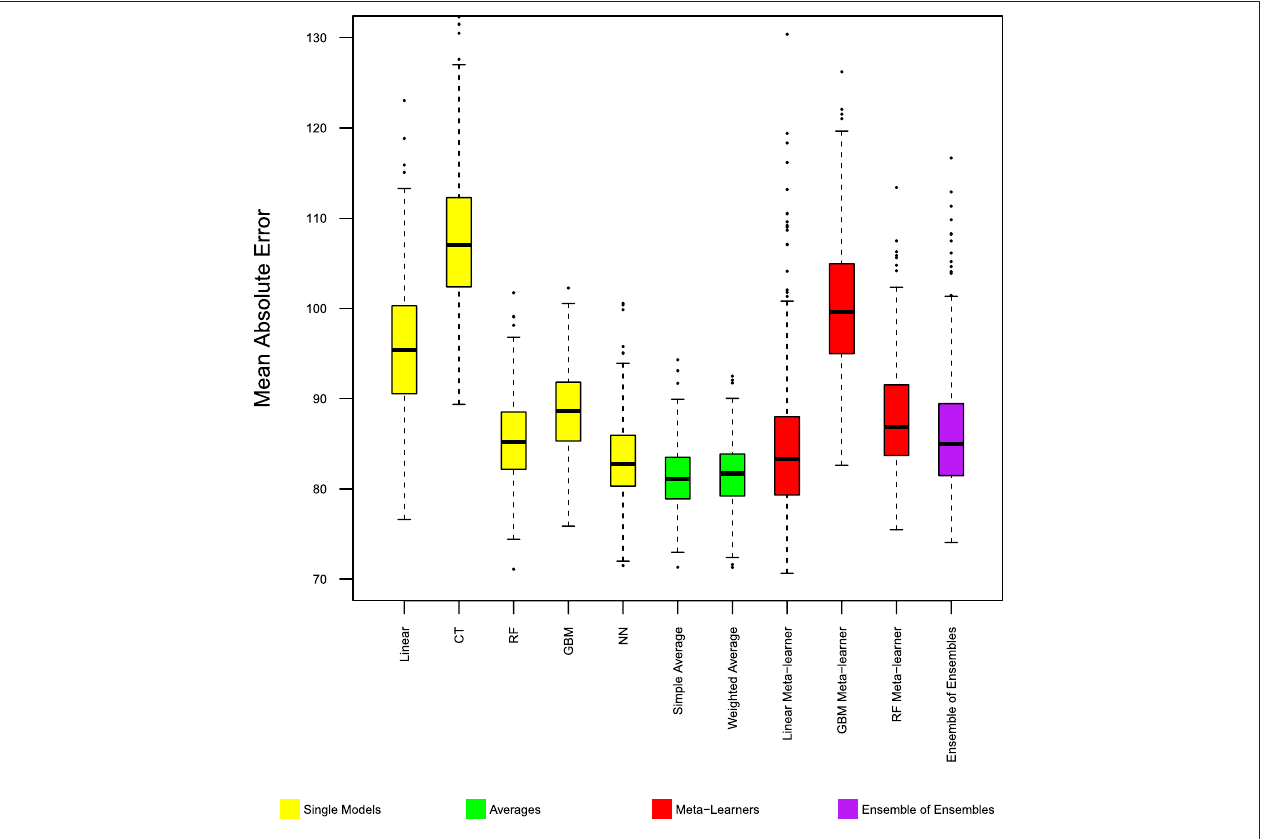
FIGURE 1 | Model performance in predicting trip production — Chicago MAE. Distribution of mean absolute error from 400 experiments. Boxes span 25th to 75th percentile, whiskers extend to max/min of the values, excluding outliers (1.5 box heights away from box edges, which are shown as dots).